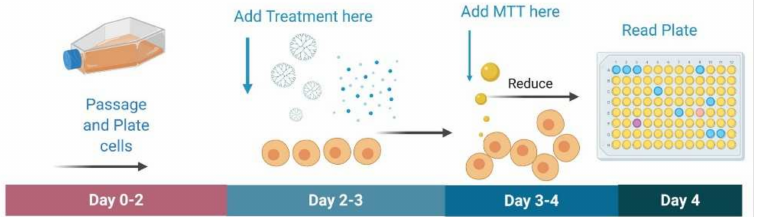
Figure 11. Schematic of MTT assay. For the MTT assay, cells are passaged and plated in a 96 well plate. Once confluent, treatment is added in triplicates to incubate for 24 h. Afterwards, MTT dye is added and incubated for four hours. MTT detergent reagent is then added and incubated for 2 h in the dark. Plates are then read on a spectrophotometer at 570